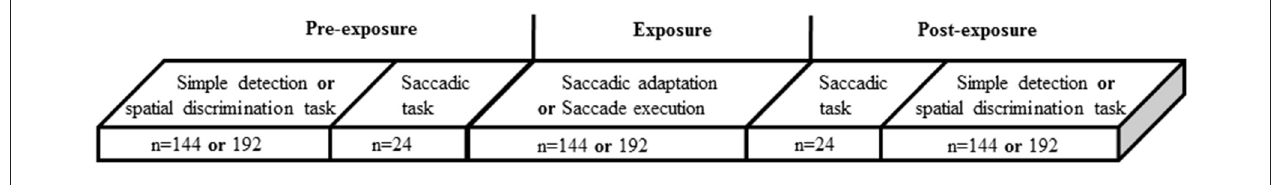
or a control block performed during the exposure phase (in Experiment II detection was replaced by spatial discrimination). The number of trials in each block (n) is indicated.